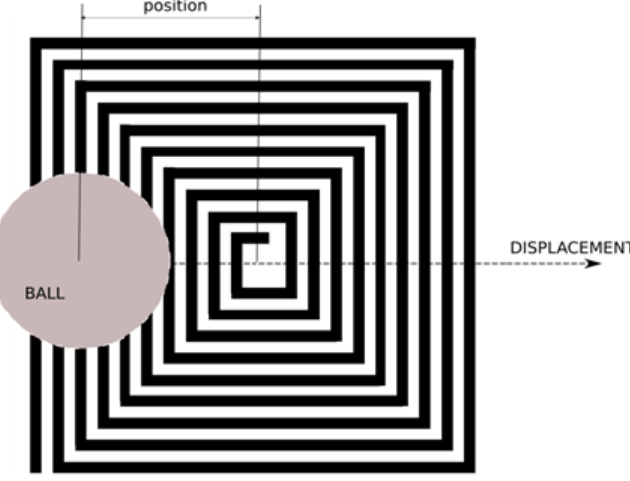
Figure 15. Drawing of the ball’s position with respect to the center of the inductor.